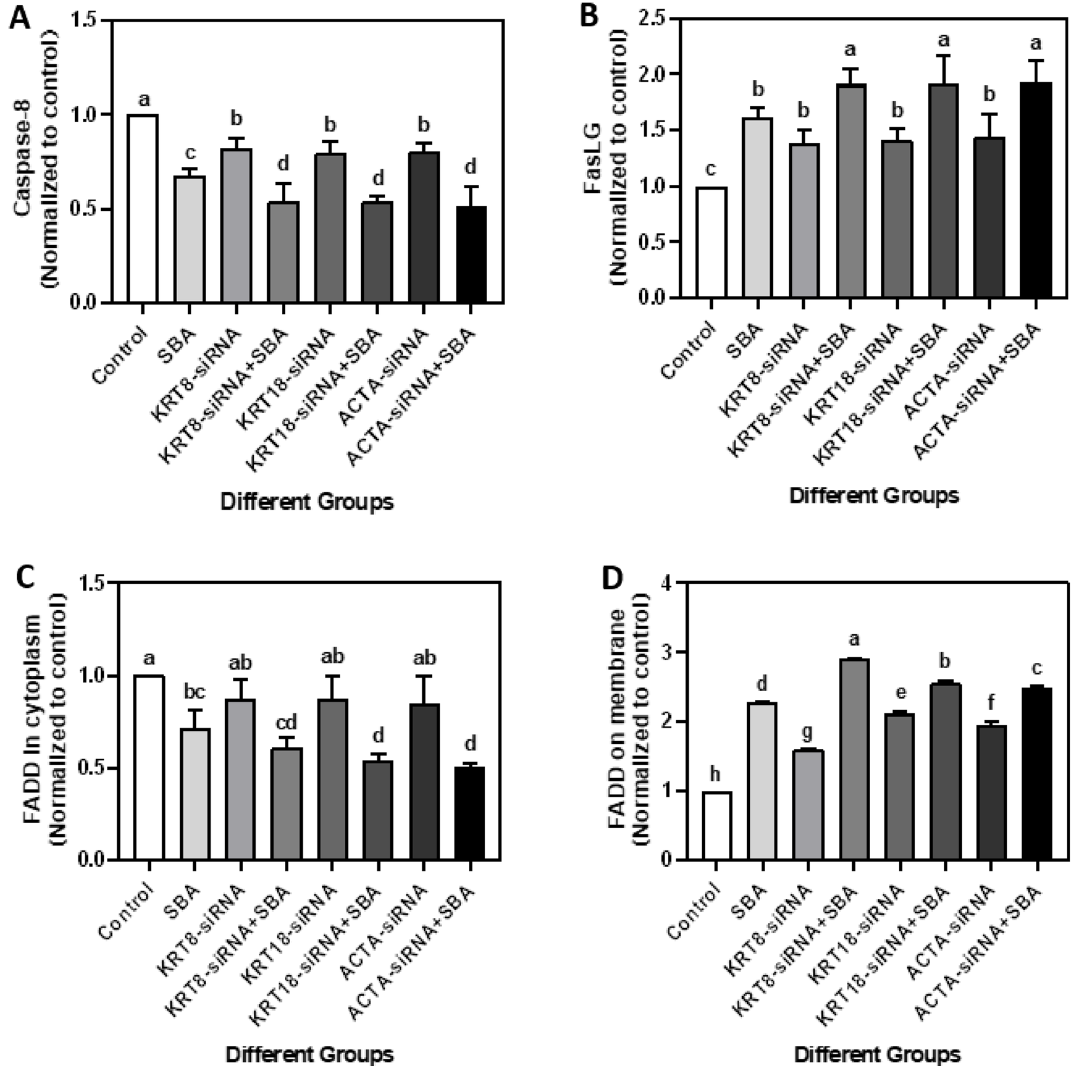
Figure 19. ( A – D ) Analysis of protein expression of death receptor-mediated signal pathway-related molecules in different treatment groups. The protein expressions in different treatments were obtained from the western blot represented. ( A ) The protein expression of Casapse-8; ( B ) The protein expression of FasL; ( C ) The protein expression of cytosolic FADD; and ( D ) The protein expression of membrane FADD. Data were analyzed using Bandscan software. Each column represents the mean ± SEM of three independent experiments. Different lowercase letters indicate the significance of differences between different treatment groups ( p <